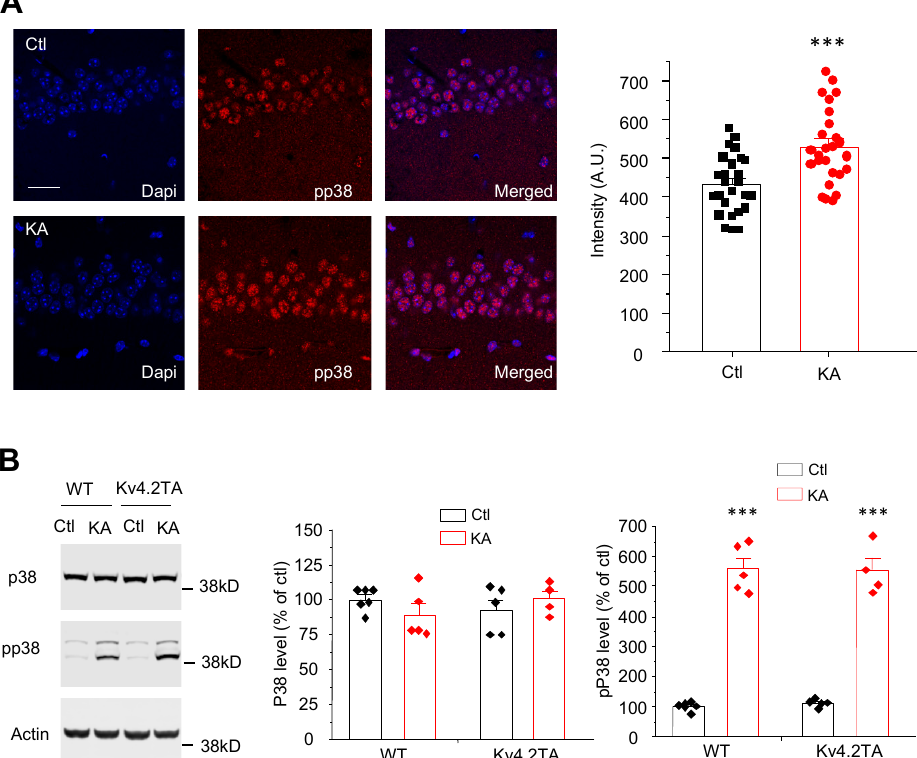
Figure 5. Kainic acid activates p38 MAPK in both WT and Kv4.2TA mice. ( A ) Immunostaining analysis showed p38 phosphorylation increased with kainic acid administration (25 mg / kg, i.p., 30 min) in mouse hippocampus, n = 26 cells in each group, t -test, *** p < 0.001. ( B ) Western blot analysis showed p38 phosphorylation increased with kainic acid administration (25 mg / kg, i.p., 30 min) in hippocampus in both WT and Kv4.2TA mice, n = 4–6 cells in each group, t -test, *** p <